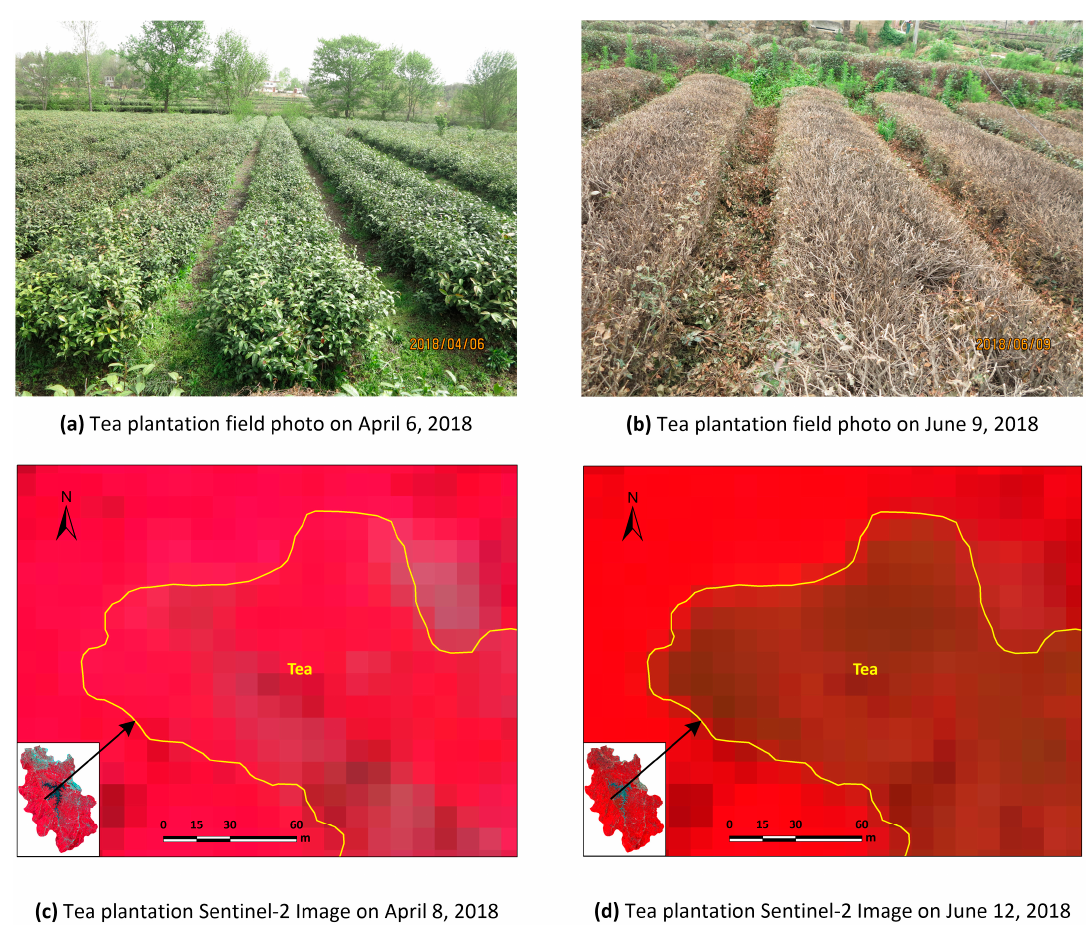
Figure 3. E ff ect of pruning on tea plantations in the study area: ( a , b ) field photos of tea plantations before and after pruning, respectively; ( c , d ) Sentinel-2 false colour images of tea plantations before and after pruning, respectively.